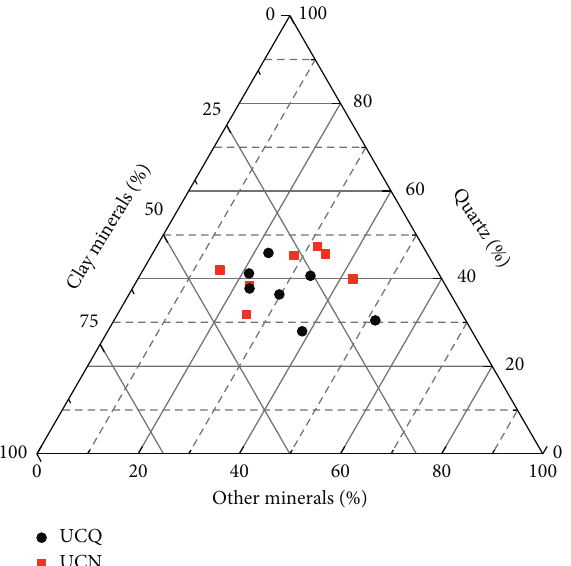
Figure 2: Mineral composition of collected samples. UCQ, Upper Cretaceous Qingshankou formation; UCN, Upper Cretaceous Qingshankou Nenjiang